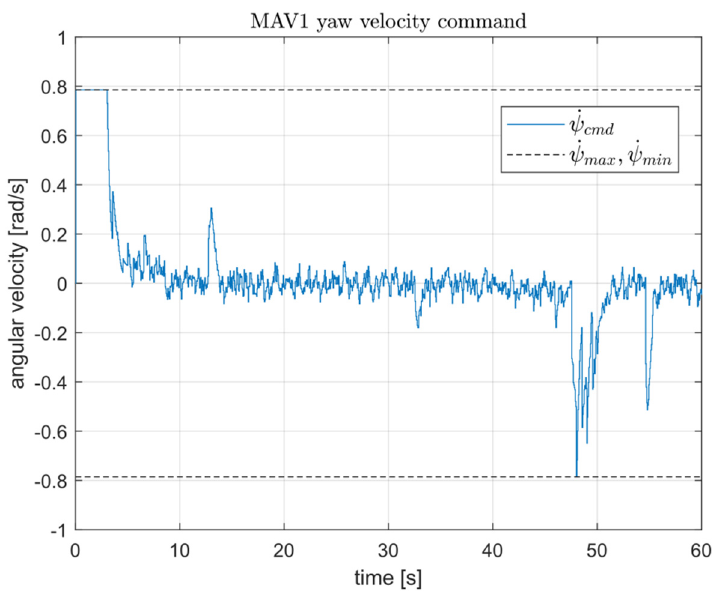
Figure 11. The yaw velocity command of the first UAV in the first minute of the simulation. It is possible to appreciate how the NMPC handles the input constraints.